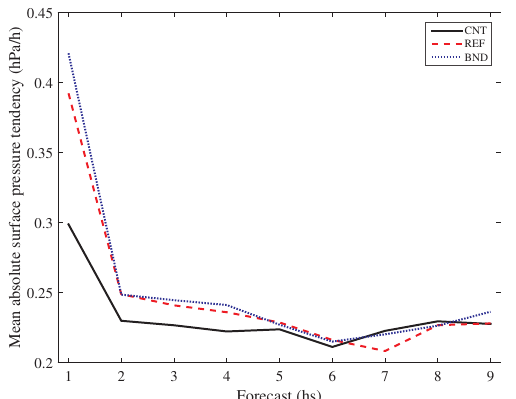
Figure 6. Mean absolute surface pressure tendency in each experiment over the global region for the period under